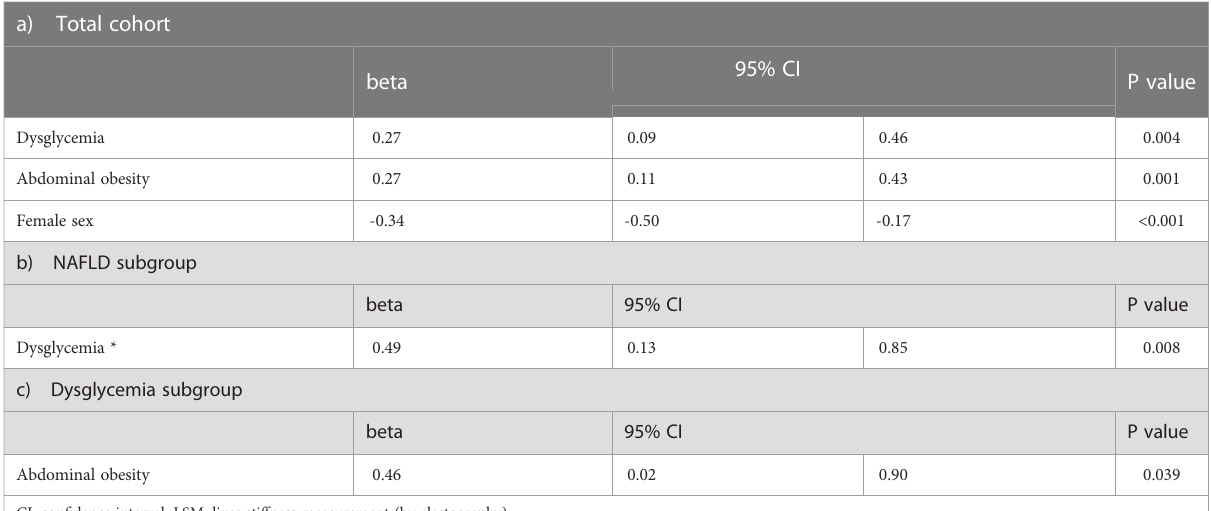
TABLE 2 Multivariate analysis of risk factors associated with an increase in LSM over